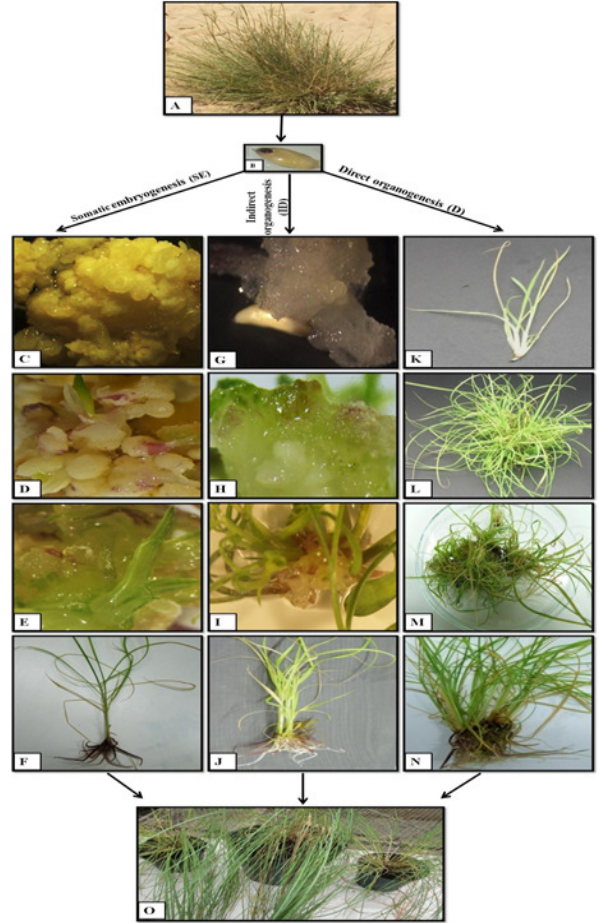
Fig. 1. In vitro regeneration from C. schoenanthus subsp. proximus :(A) Wild plant with mature inflorescence; (B) Mature seed under light microscope; (C) Embryogenic callus, (D) Embryogenic callus with mature somatic embryos; (E) Embryogenic callus with germinating somatic embryos; (F) Rooted plant; (G) Non embryogenic callus; (H) Organogenic callus; (I) Indirect regenerated shoots; (J) Rooted plant; (K) Direct regenerated shoots 1 week old; (L) Direct regenerated shoots 3 weeks old; (M) Direct regenerated shoots 5 weeks old; (N) Rooted plant and (O ) Acclimatized